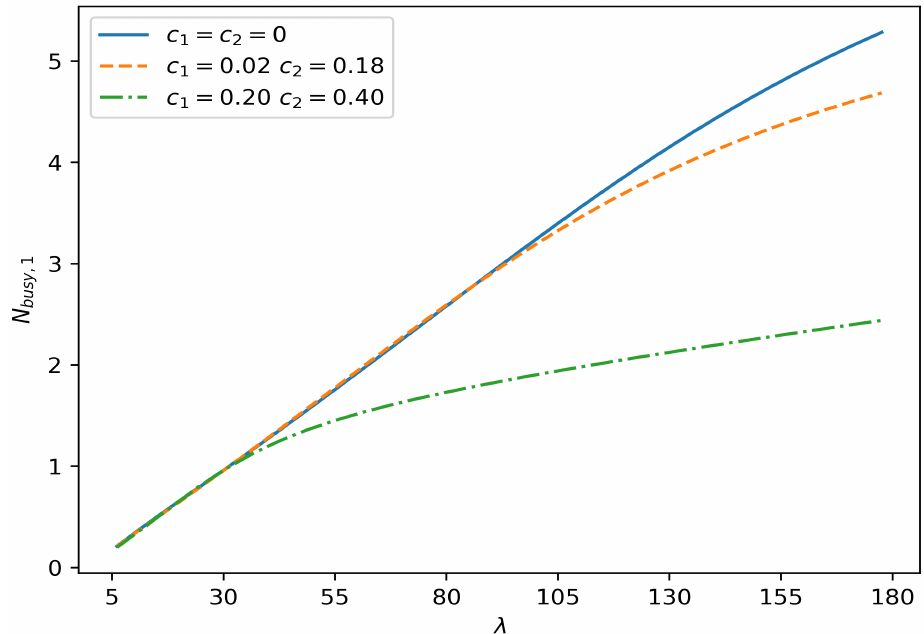
Figure 4. Dependence of the mean number N busy ,1 of servers providing service to priority customers on the input rate λ for the MMAP s with different coefficients of correlation.